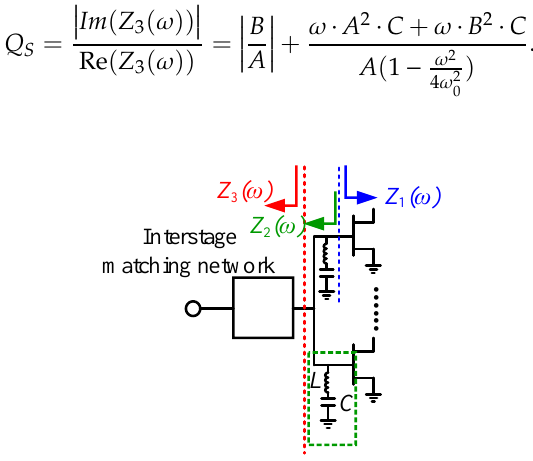
Figure 8. The simulated response of the output matching network from 8 GHz to 21 GHz. Figure 9. The LC series resonant network and the planes of Z 1 ( ω ), Z 2 ( ω ), and Z 3 ( ω ).